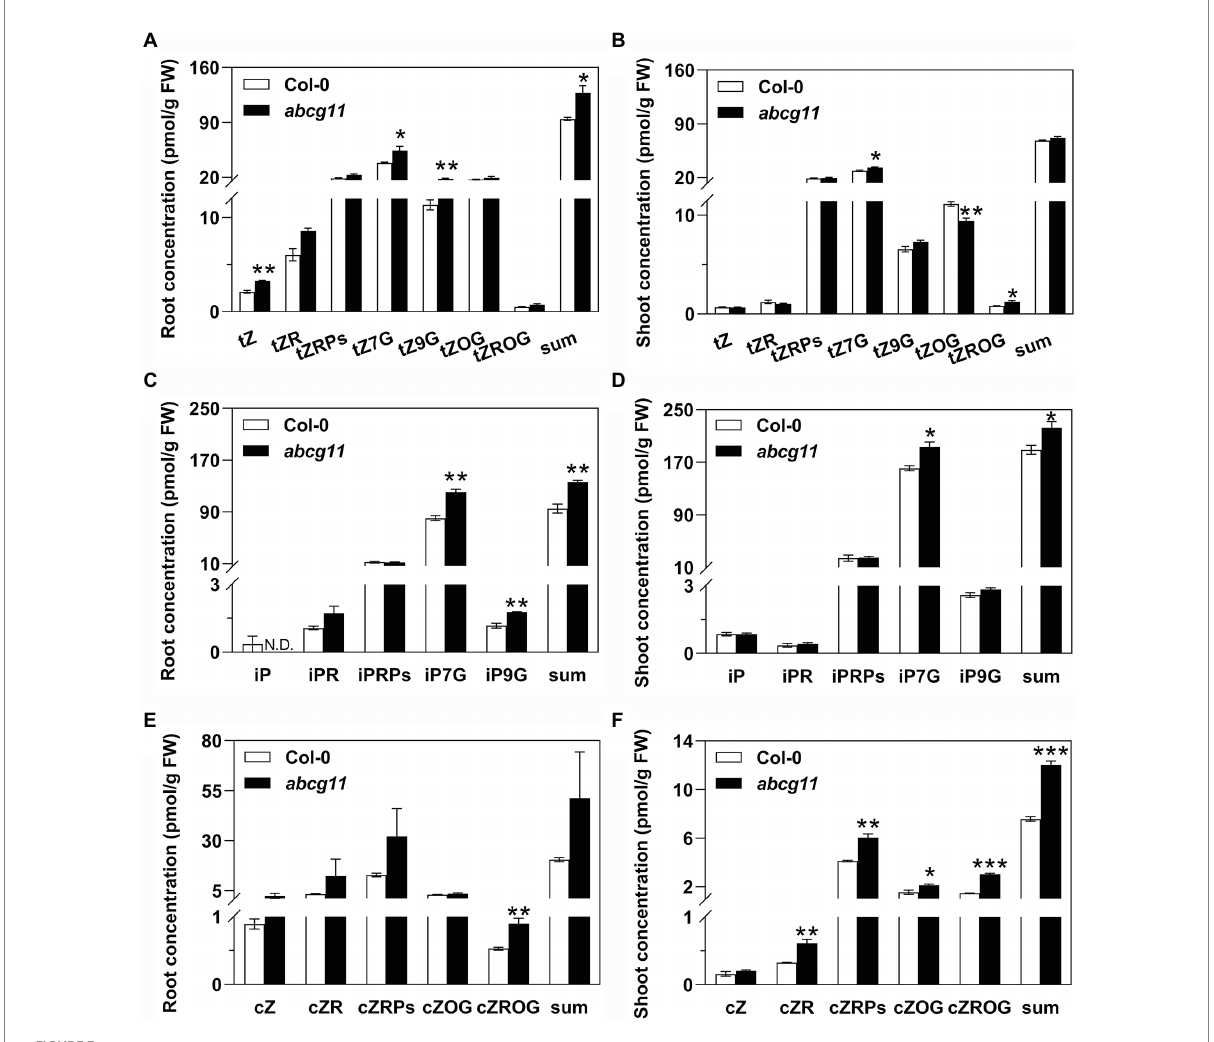
FIGURE 3 The concentration of several cytokinin types is higher in abcg11 than in the wild type. Concentrations for the trans -zeatin (tZ)-type (A,B) , isopentyladenine (iP)-type (C,D) , and cis -zeatin (cZ)-type (E,F) cytokinins in roots (A,C,E) and shoots (B,D,F) of Col-0 and abcg11 . Seedlings were grown on half-strength MS medium for 12 d under long-day conditions (16 h light/8 h dark). Data are shown as means ± SE ( n = 4). Asterisks represent significant differences by Student’s t -test: * p < 0.05; ** p <